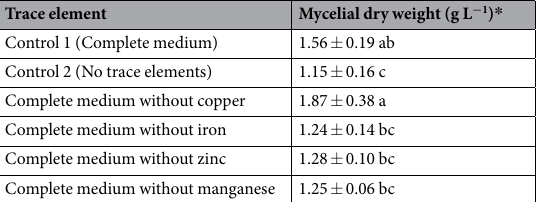
Table 10. Effects of trace element on the mycelial growth of Isaria farinosa . * Mean ± SE. Values followed by the same letters within a column do not differ significantly (ANOVA, P = 0.05).